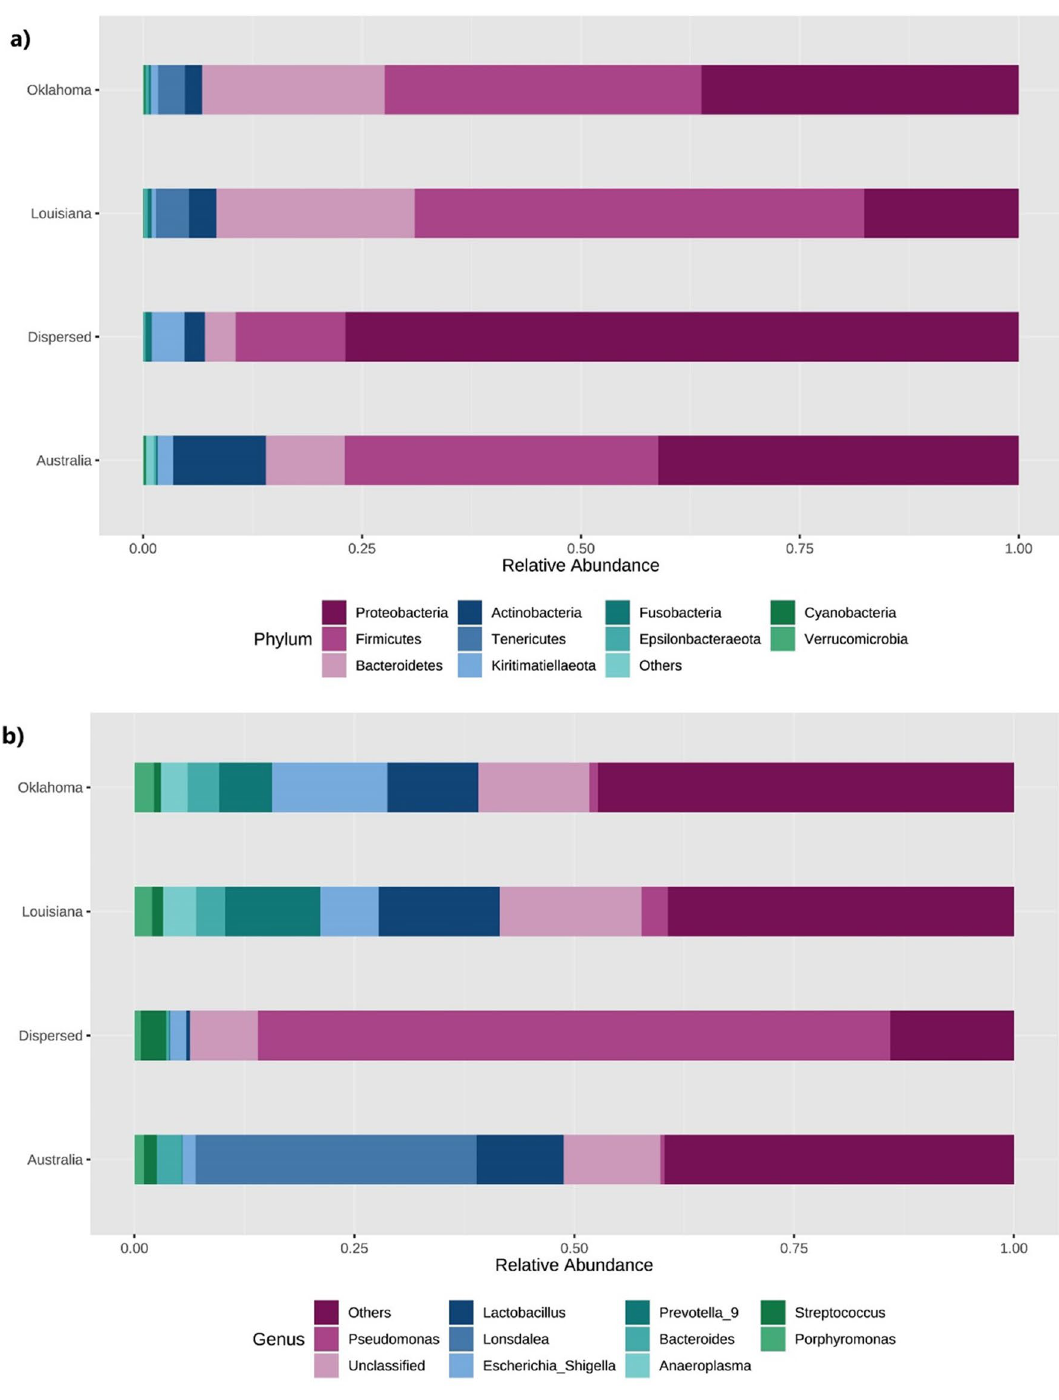
Figure 7. The microbial community structure and composition of endometrial lavage samples of mares belonging to Oklahoma, Louisiana, Australia, and Dispersed groups . Stacked bar graphs generated depict the relative abundance of the top 10 phyla ( a ) and genera ( b ) identified and grouped according to their geographical